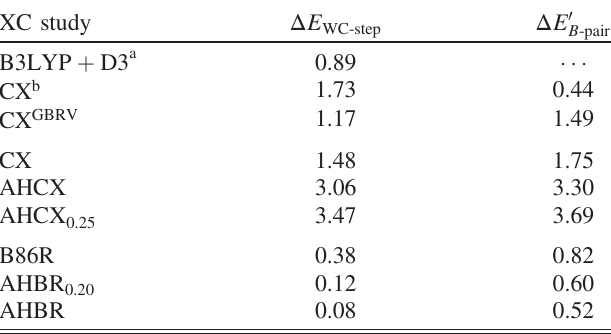
TABLE VII. Comparison of the CX-based and B86R-based tool-chain performance for DNA assembly. We report MAD values (in kcal/mol) as extracted by averaging the deviations of vdW-DF results relative to coupled-cluster calculations [225] on the ten different base-pair stacking configurations, using the specific configurations that are provided in Ref. [225]. We report on ONCV-SG15/160 Ry results, but we also compare with the literature values as well as an assessment obtained from a separate ultrasoft-PP study ( “ GBRV ” ). The reference calculations use DLPNO - CCST ( T ) [228] to compute the step energy Δ E WC-step and Δ E 0 B -pair which is a sum over relevant molecular-pair contribu-